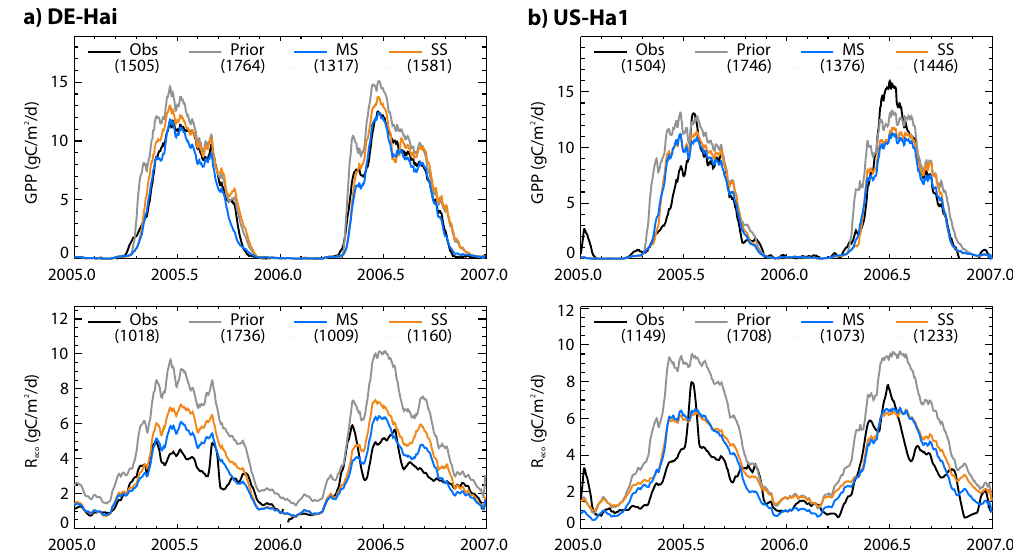
Fig. 8. Seasonal cycle of GPP and R eco at (a) Hainich and (b) Harvard Forest sites, smoothed with a 15-day moving average window. The estimations derived from flux-partitioning of NEE (black) are compared with the prior model (grey), the MS optimization (blue) and the SS optimization (orange). The averaged annual fluxes in gCm − 2 yr − 1 are given between